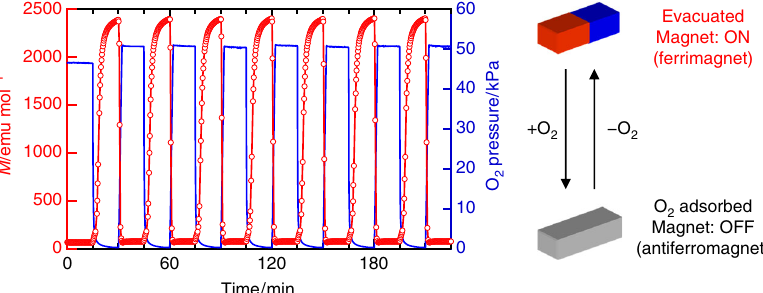
Fig. 6 Magnetic switching by introducing/evacuating O 2 gas into/from 1 . Time course of the magnetization (red circle) while the O 2 pressure (blue line) alternated between <0.1 and 50 kPa every 15 min under a 100 Oe magnetic fi eld at 85